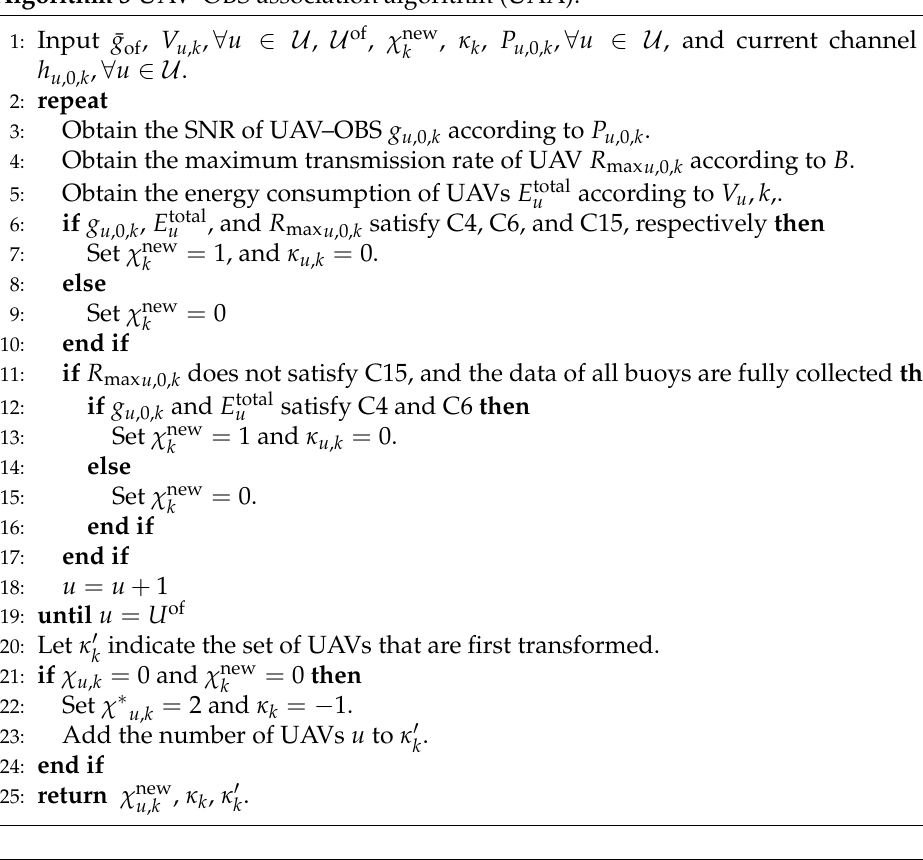
Algorithm 3 UAV–OBS association algorithm (UAA).